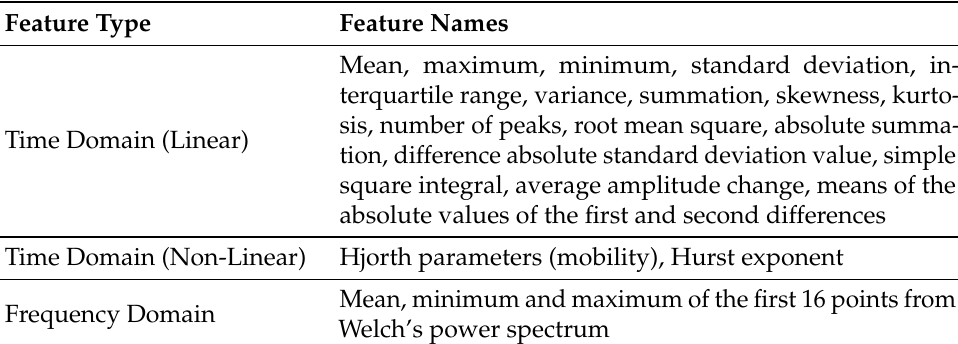
Table 2. Features Extracted from fNIRS